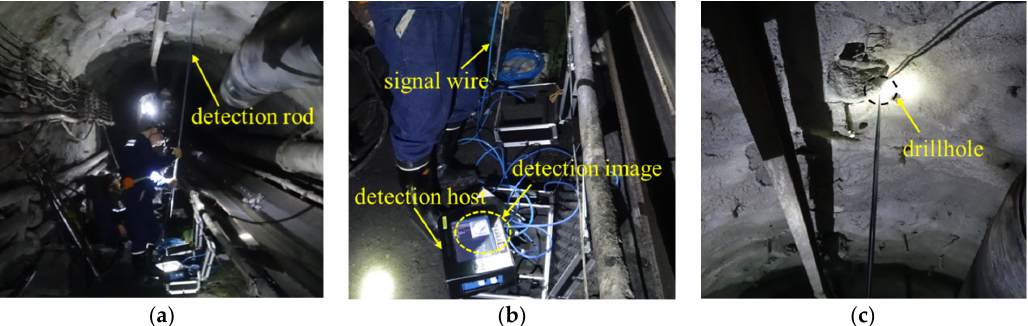
Figure 11. Drillhole detection in the field. ( a ) Impel detection rod, ( b ) observation of internal situation, and ( c ) drillhole location.